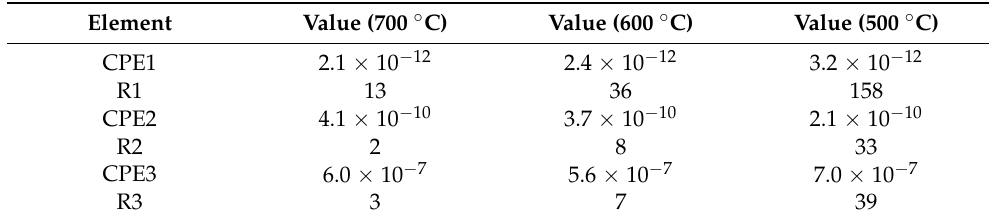
Table 2. Results of Nyquist-plots fitting, where CPE is the constant phase element (F), and R is the resistance (k Ω ·